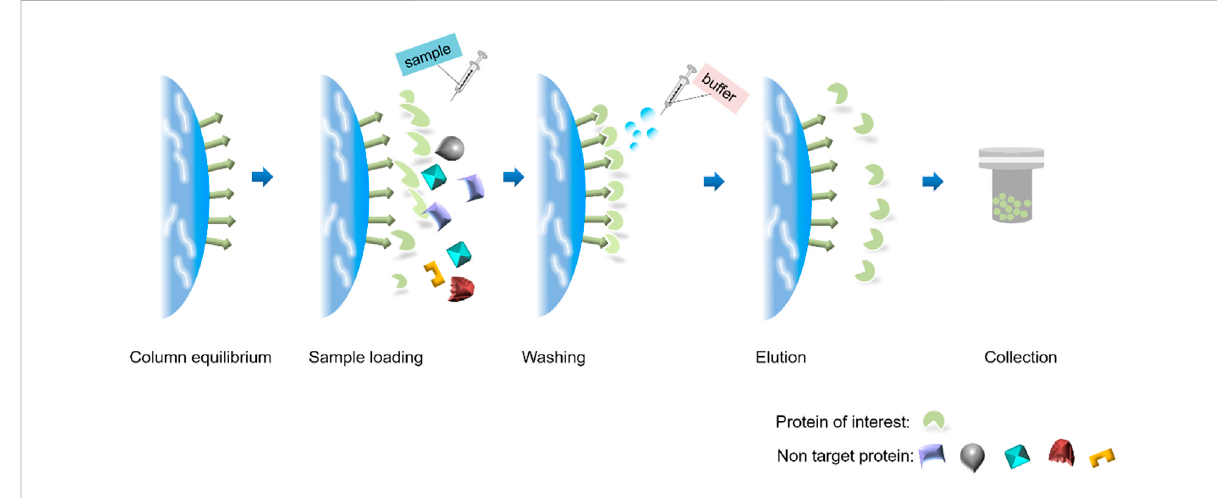
FIGURE 7 Af fi ntiy chromatography